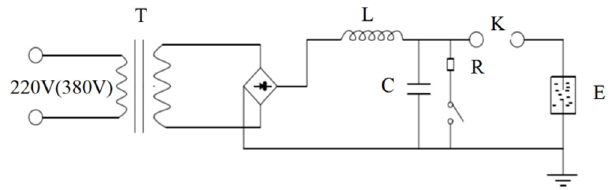
Figure 4. Schematic diagram of the discharge device circuit.